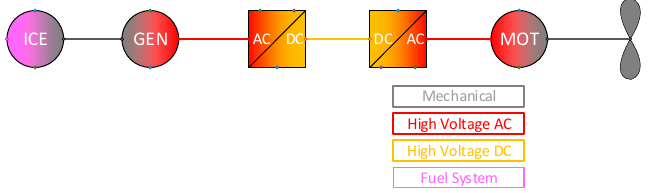
Figure 8. Turbo-electric propulsion system.